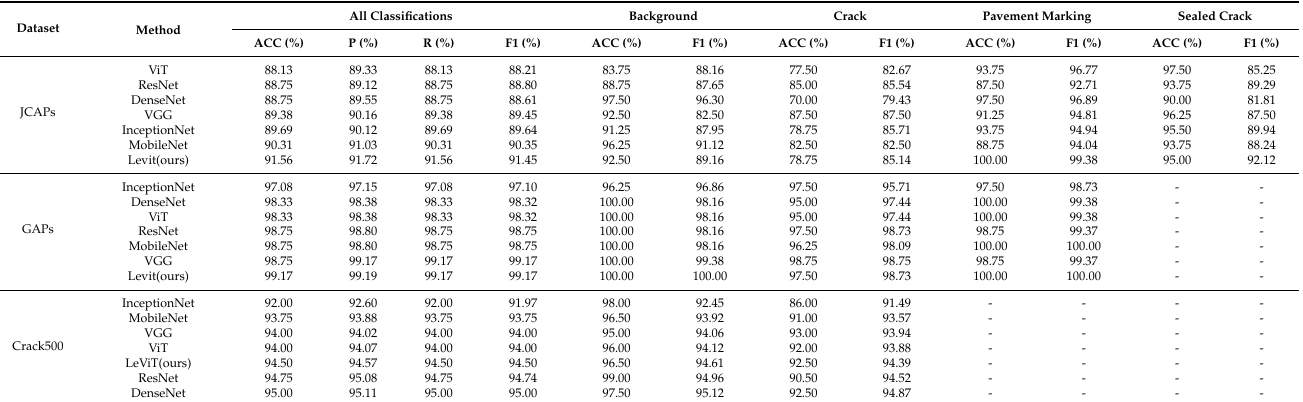
Table 3. Classification results of different methods based on different